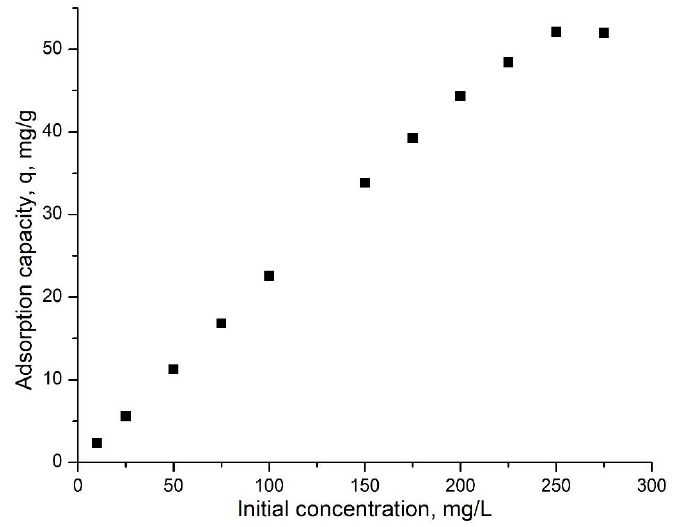
Figure 7. The Ru(III) initial concentration influence (pH 2, contact time 120 min, 298 K).